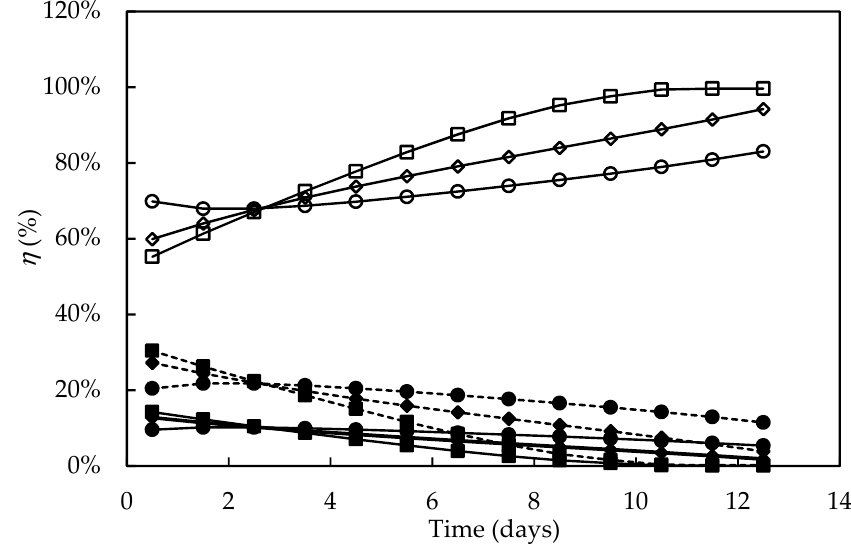
Figure 8. Percentage distribution of the light energy absorbed during Dunaliella tertiolecta cultivations in different culture media. Energy fixed by the photosystems (dashed line), energy transformed into ATP (continuous line, full symbols), energy released as heat (open symbols). F/2 medium ( , ), Bold’s Basal medium ( , ), Alternative medium ( , ).